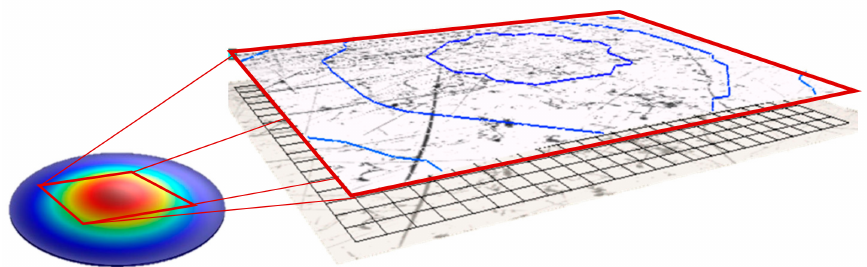
Figure 6. Image of the first resonant mode at 6 V RMS obtained by measurement with the laser Doppler vibrometer, at the center of a 12 mm membrane, and comparison with the expected theoretical mode shape, obtained by FEM